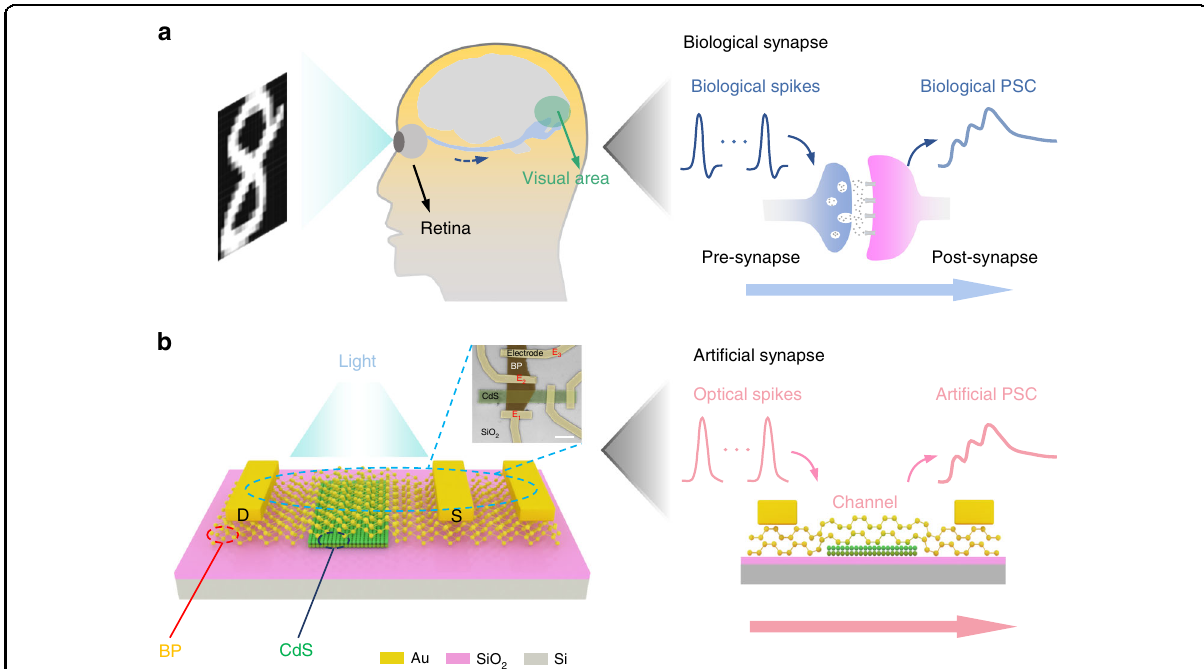
Fig. 1 Comparison of the biological synapse with the designed arti fi cial synaptic device. a Schematic illustration of human visual sensory system. The right panel of fi gure describe the responses to biological spikes in the biological synapse. b Schematic structure of the arti fi cial photonic synapse based on BP/CdS vdWs heterojunction. Upper panel: top-view scanning electron microscope (SEM) image of the device; scale bar, 5 μ m. The light green strip is CdS, while the brown area indicates the BP fl ake. The right panel of fi gure describe the responses to optical spikes in the arti fi cial synapse, Cr/Au (10 nm/50nm) electrodes are only contact with